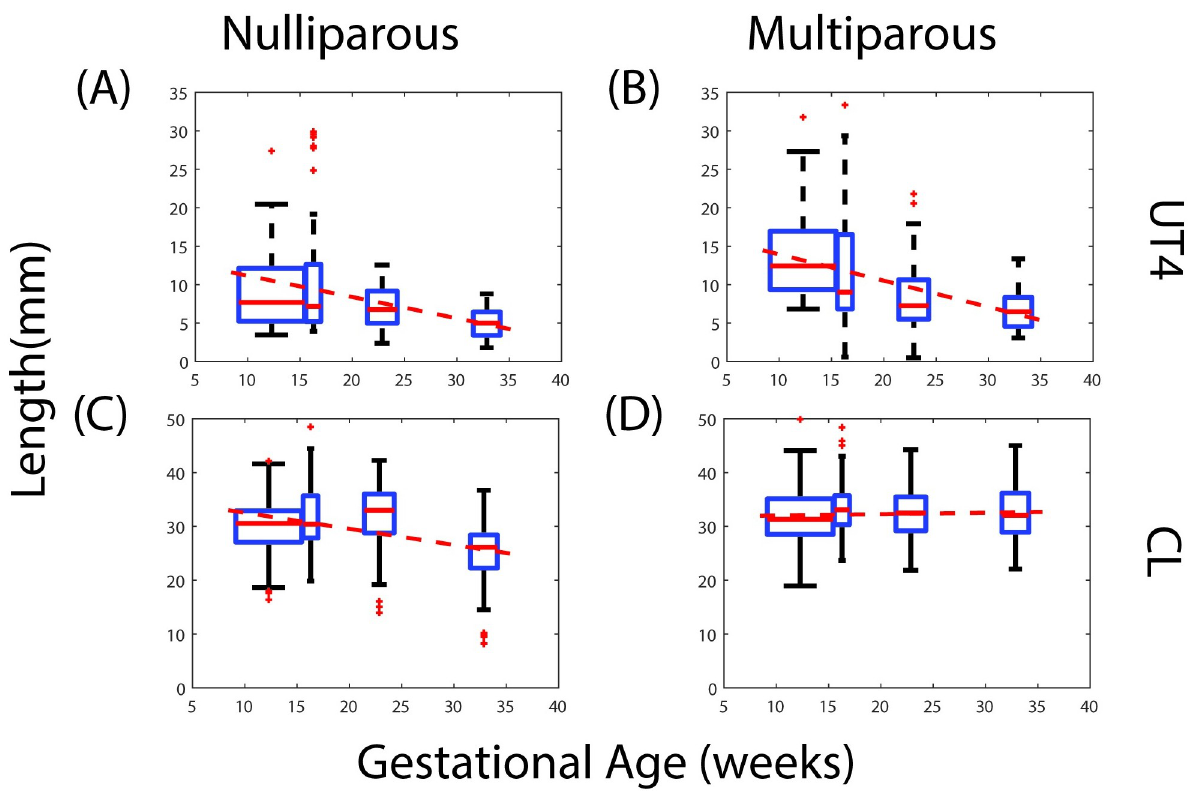
Fig 6. Effect of parity on ultrasonic maternal anatomy measurements across gestational age. Box and whisker plots for lower uterine segment thickness (UT4) and cervical length (CL) for nulliparous and multiparous patients.